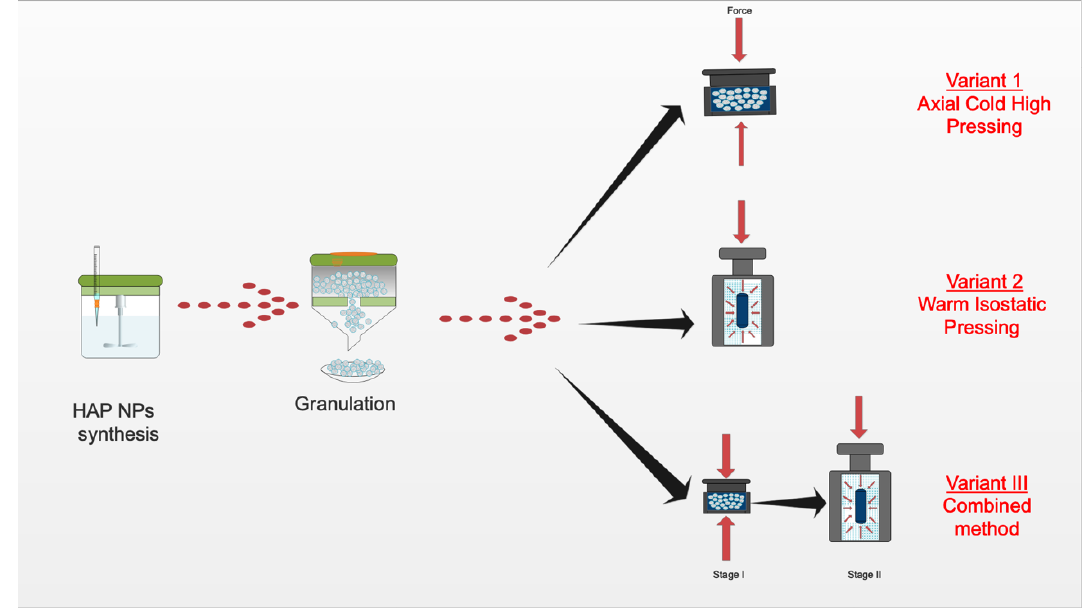
Figure 2. Diagram of the 80% HAP NPs + 20% PLA composite production process.